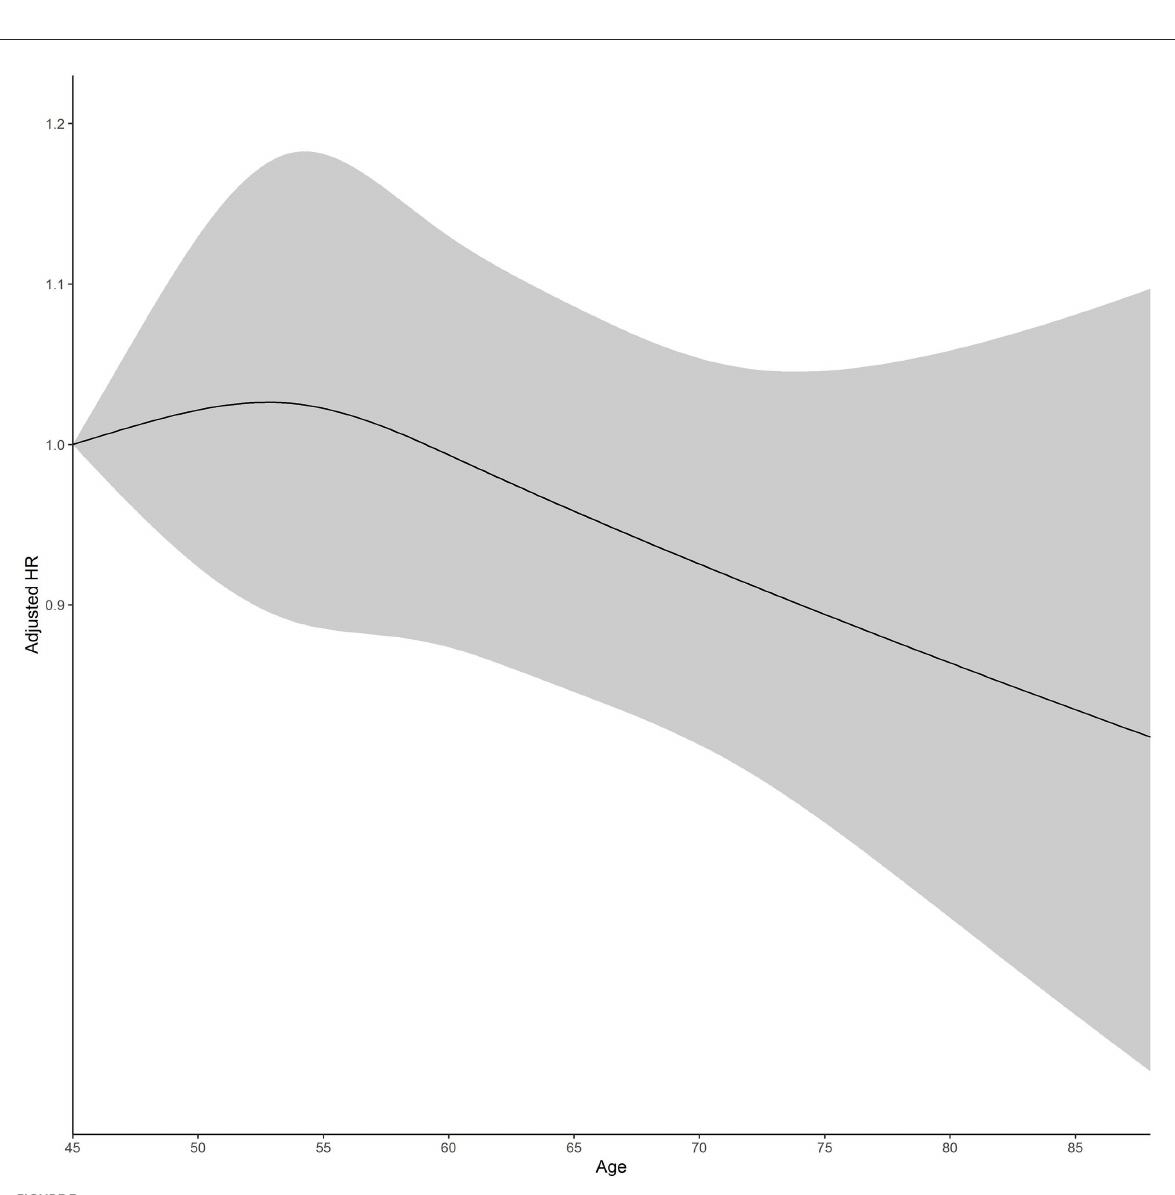
FIGURE3 Adjusted hazard ratios (HRs) of depressive symptoms, according to age. Graphs show HRs for depressive symptoms adjusted for vision and hearing scores, sex, residence, marital status, educational level, smoking history, alcohol consumption, hypertension, diabetes, heart disease, digestive disease, arthritis, wearing glasses, and wearing a hearing aid. Data were fitted by a restricted cubic spline Cox proportional hazards regression model. The vision and hearing scores range from 45 to 85. Solid lines indicate HRs, and dashed lines indicate 95%